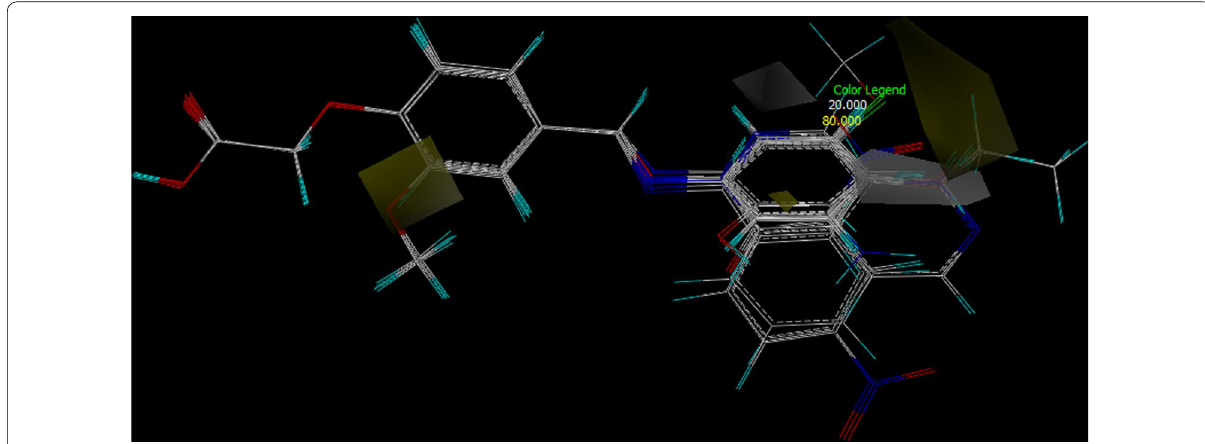
Fig. 11 CoMSIA hydrophobic SD coefficient contour plot; yellow contours indicate regions where hydrophobicity favors and white contours × indicate regions where hydrophobicity